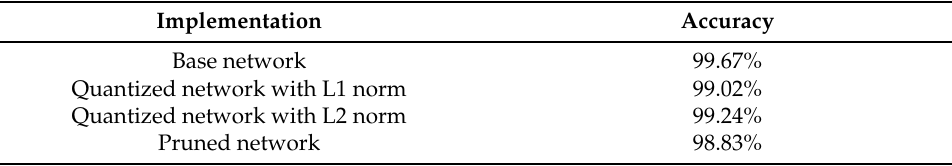
Table 1. Accuracy obtained for the different approaches.